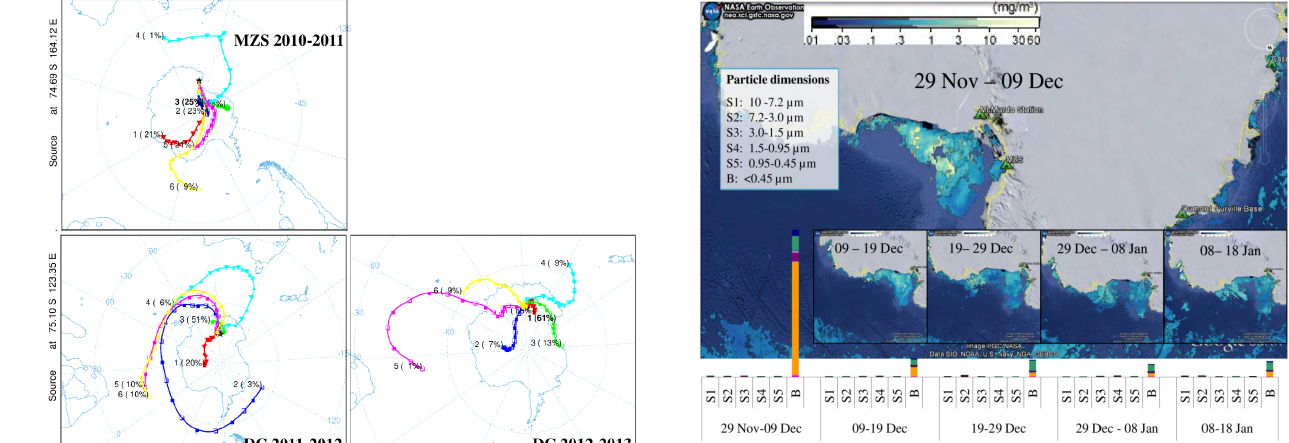
Figure 3. Cluster means backward trajectories analyses at 500m aglat the coastal base “Mario Zucchelli Station” (MZS) during the summer of 2010–2011 and cluster means backward trajectories at the Italian–French base Dome C (DC) during the summers of 2011– 2012 and 2012–2013.